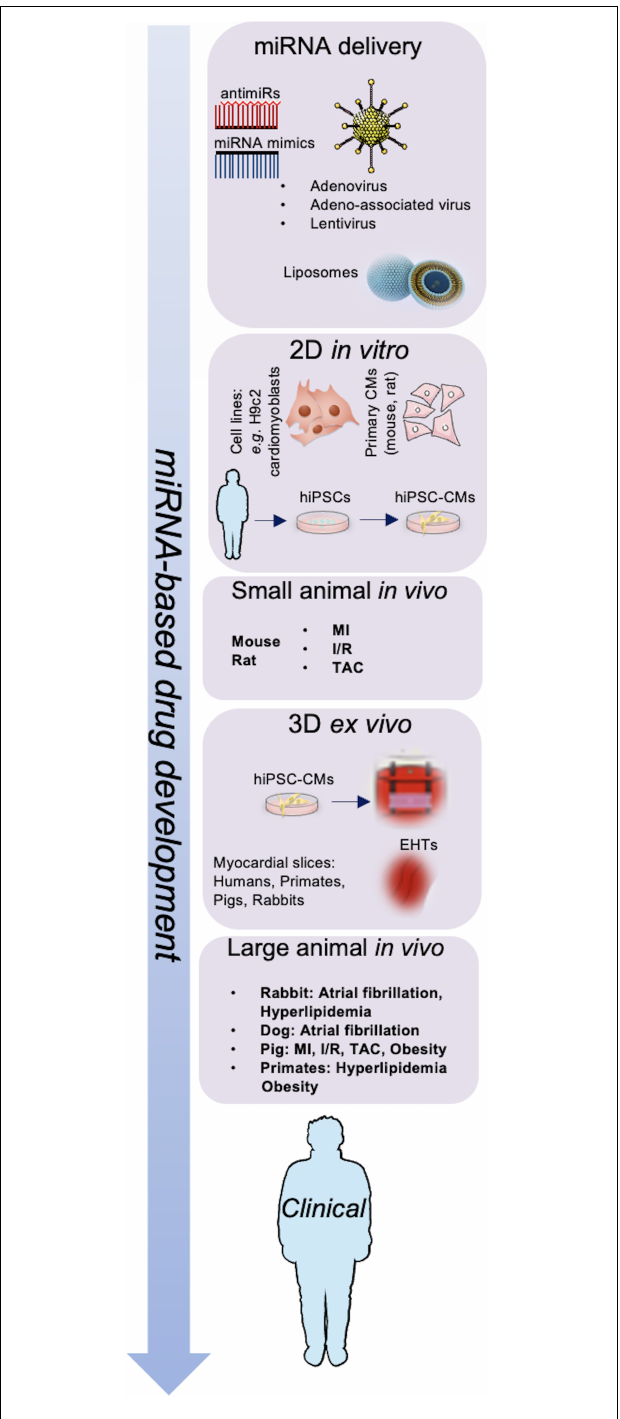
FIGURE 1 | Schematic representation of miRNA-based drug development. Adenovirus, adeno-associated virus (AAV), lentivirus particles, and liposomes are used to deliver miRNA mimics or antimiRs; miRNAs are investigated in vitro , in vivo , and ex vivo models to develop next-generation therapeutics for cardiovascular diseases. CMs, cardiomyocytes; EHTs, engineered heart tissues; hiPSCs, human induced pluripotent stem cells; I/R, ischemia-reperfusion; MI, myocardial infarction; TAC, transverse aortic